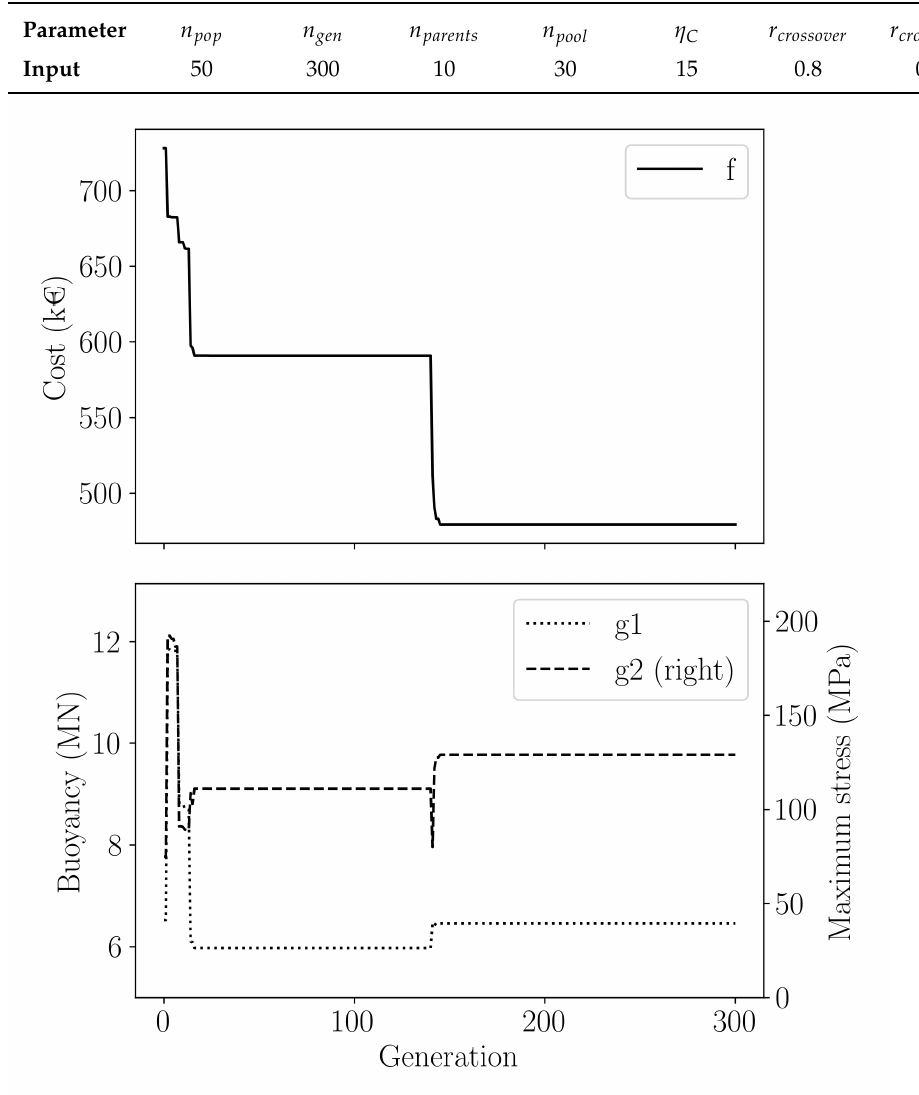
Table 9. Parameters of the basic Genetic Algorithm used.